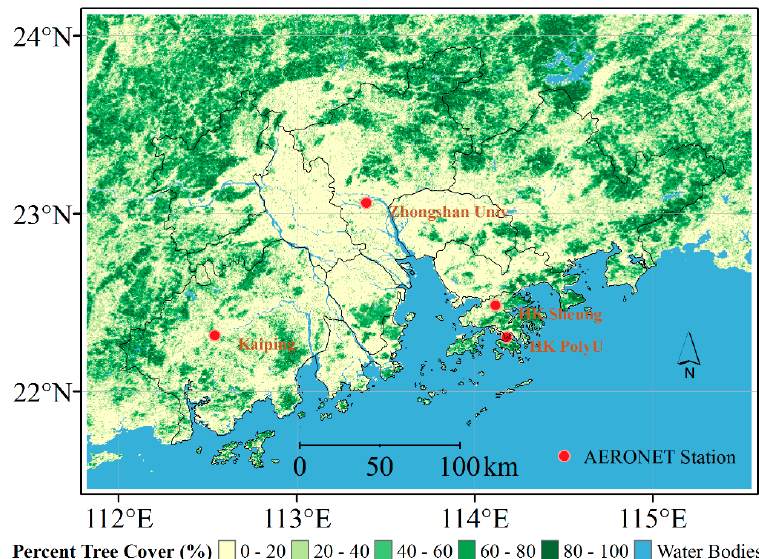
Figure 1. Map of the study area with locations of the AERONET stations used for validating satellite AOD products. Percentile tree cover obtained from the Center for Environmental Remote Sensing, Chiba University represents the density of trees over this region.